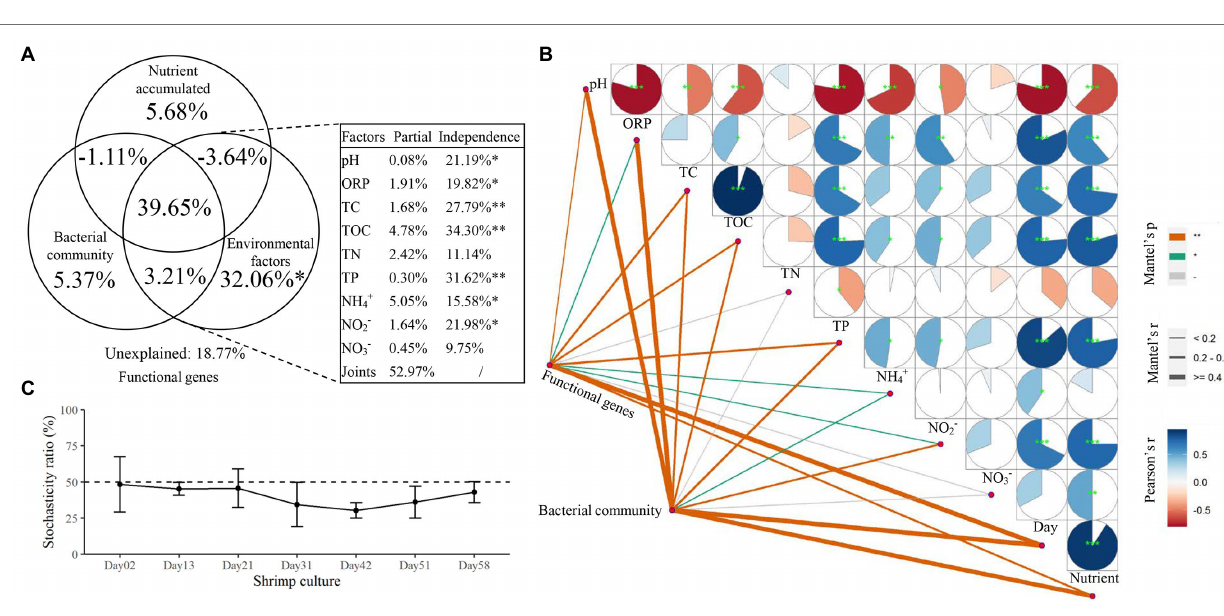
FIGURE 5 | The relationships of functional genes with additive nutrients, environmental factors, and the bacterial community. (A) Variation partition analysis (VPA) shows the effects of environmental factors, additive nutrients, and the bacterial community on the functional genes. (B) Interactions among functional genes, the bacterial community, and environmental factors. (C) Stochasticity analysis of the bacterial community. * p < 0.05 and ** p <